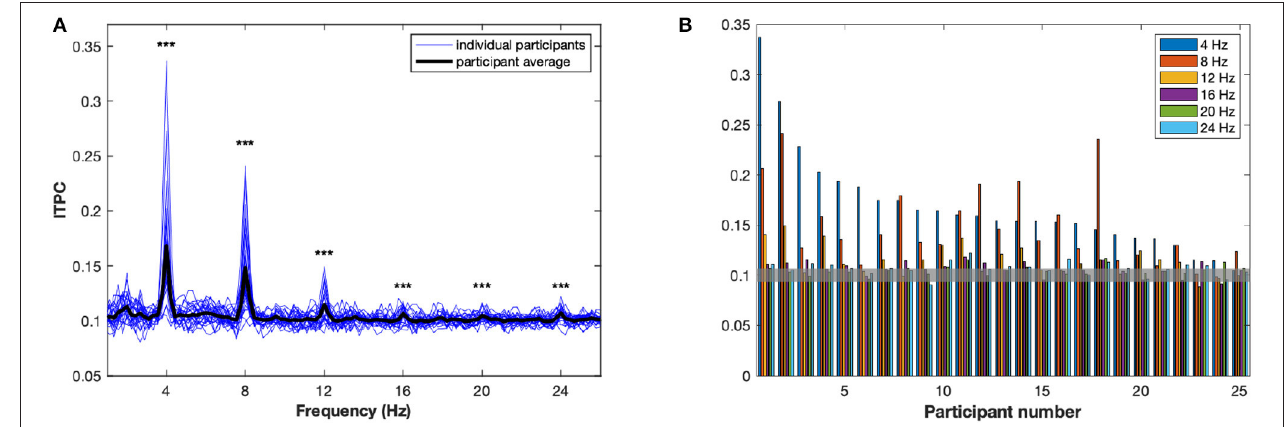
FIGURE 2 | The inter-trial phase coherence (ITPC). (A) The ITPC, averaged over channels and conditions, is plotted as a function of frequency, between 1 and 26 Hz. The bold black line represents R ( f ), the average over all participants. Each of the blue lines represents a R ( f , a ), the average for an individual participant a . Significant peaks can be observed at 4, 8, 12, 16, 20, and 24 Hz. *** p < 0.001. (B) Significant peaks in ITPC are plotted for each participant. The value 0.1 of the ITPC represents the mean ITPC for random phases, at 95% confidence intervals: consequently, any bar above the value of 0.105 is above the significance